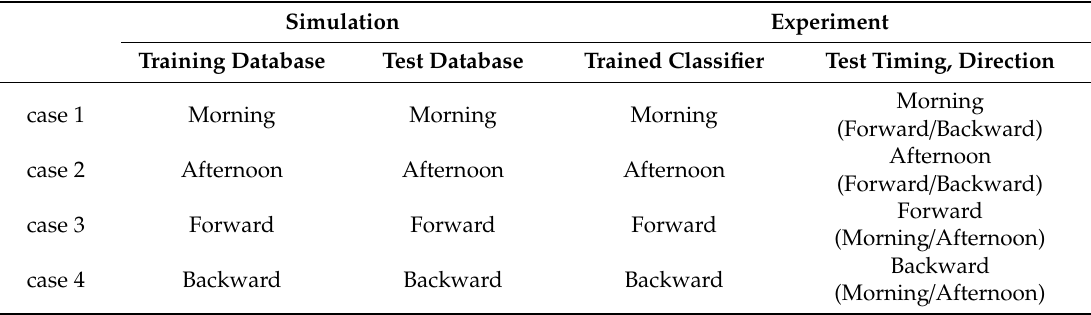
Table 3. Simulation and experiment